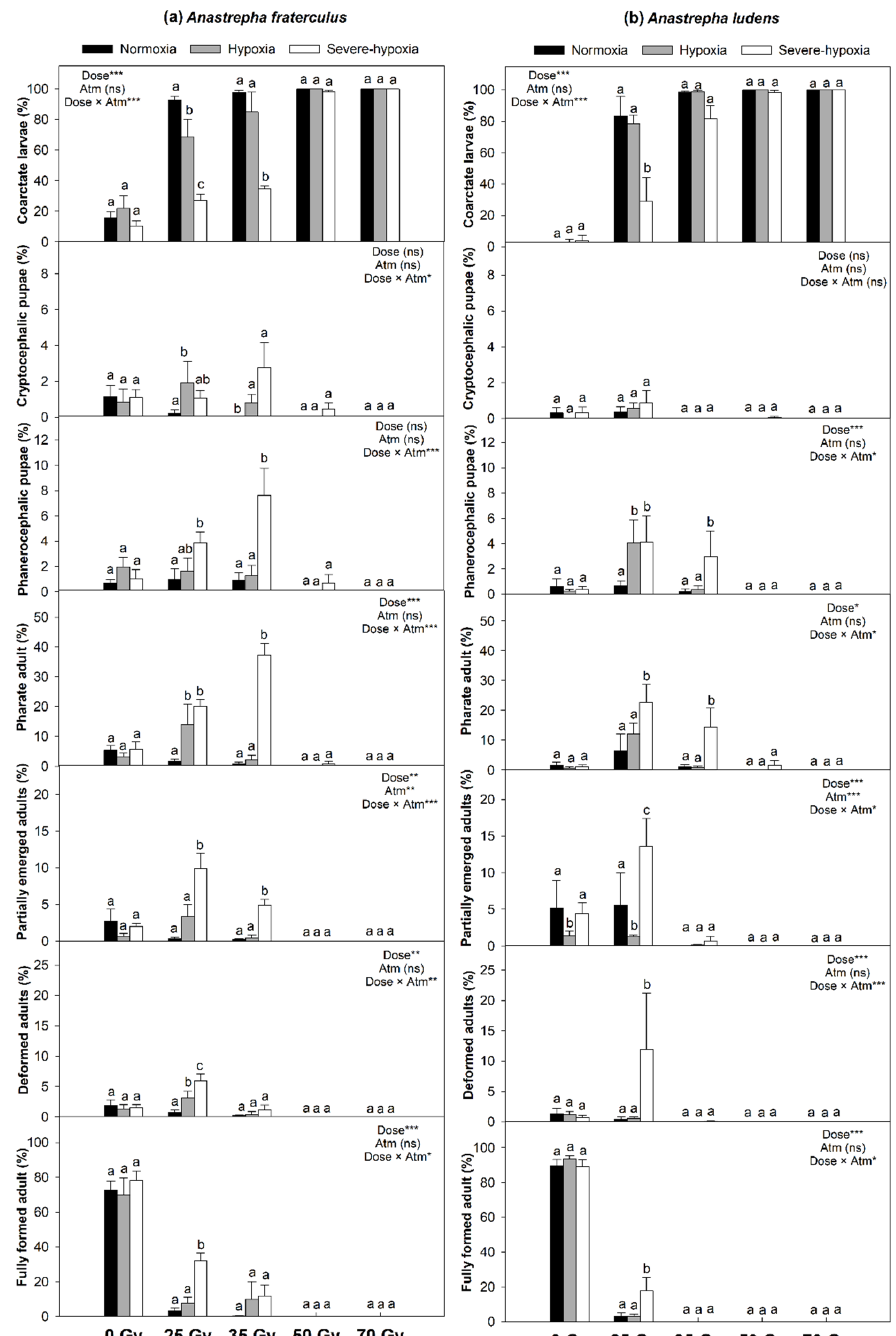
Figure 1. Percentages (mean ± SE) of dead insects dissected from puparia and emerged adults of ( a ) A. fraterculus and ( b ) A. ludens after irradiation of third instars at different nominal doses and atmospheric conditions and their controls. Generalized linear mixed model (GLMM) for the effect of dose, atmosphere (atm), and their interaction on each developmental stage (‘***’ p < 0.0001, ‘**‘ p = 0.001, ‘*’ p < 0.05, ns = non-significant). Bars followed by different letters within the same radiation dose are significantly di ff erent from each other ( p < 0.05). Details in Table S7 ( A. fraterculus ) and Table S8 ( A. ludens